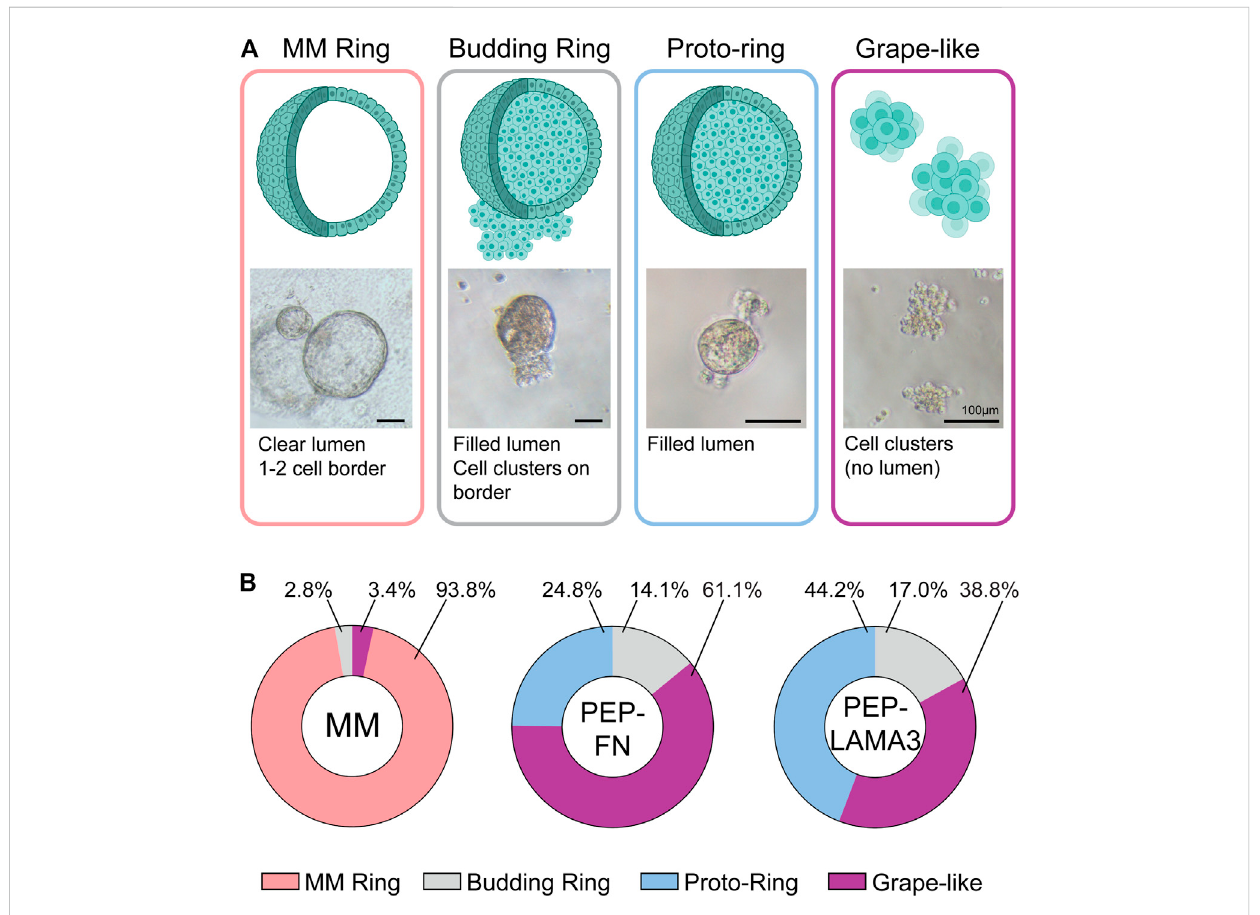
FIGURE 2 PEP-FN and PEP-LAMA3 hydrogels support the formation of novel types of colonies from pancreatic progenitor cells from 8-day-old mice. (A) Representative photomicrographsofvarious colonytypes.Cartoon rendition andshortdescriptionofeachtypeisalso shown (B) Theproportionofeach colony type grown in different materials is shown. Supplementary Table S4 (i.e. “ Data were derived from a total of three to six replicates from three experiments, see Supplementary Table S4.